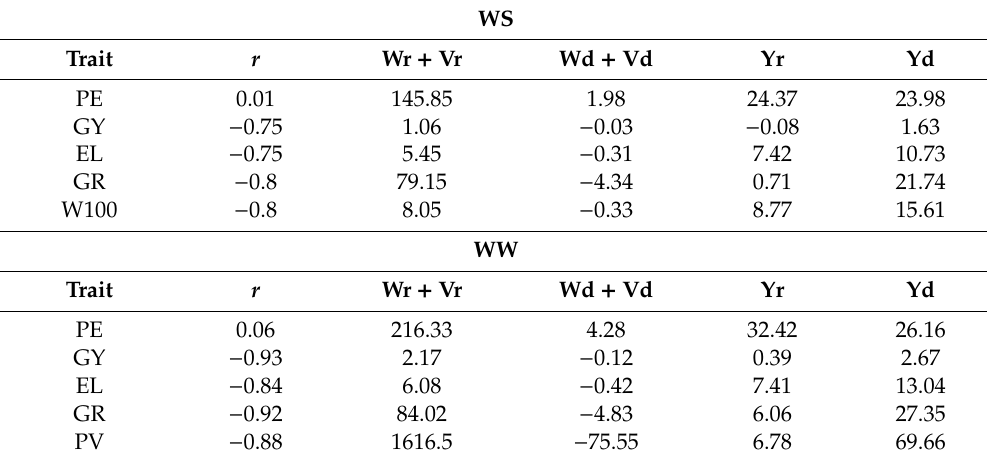
Table 7. Estimates of the expected values of the sum of the coordinates ˆ W R , ˆ V R and ˆ W D , ˆ V D , and genotypic values ( Y R , Y D ) of the parent with the highest concentration of recessive ( R ) and